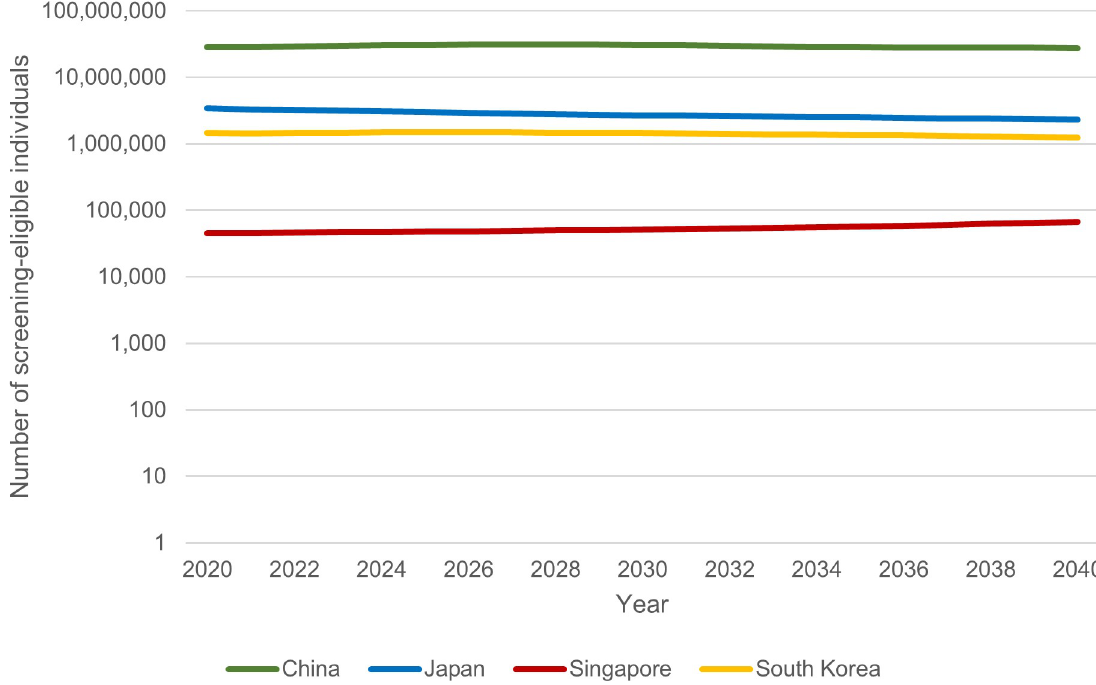
Fig 3. Number of people eligible for screening, 2020–2040. Y-axis uses a logarithmic scale.